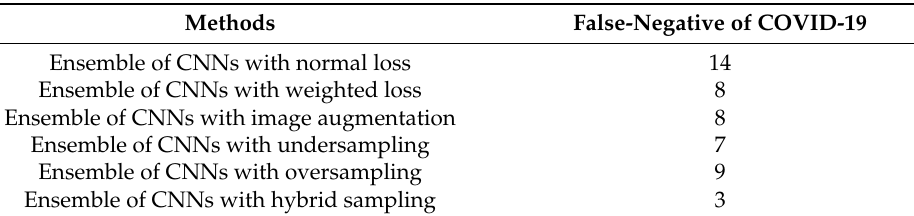
Figure 16. ROC curves (true positive rate vs. false positive rate) of each ensemble classifier.